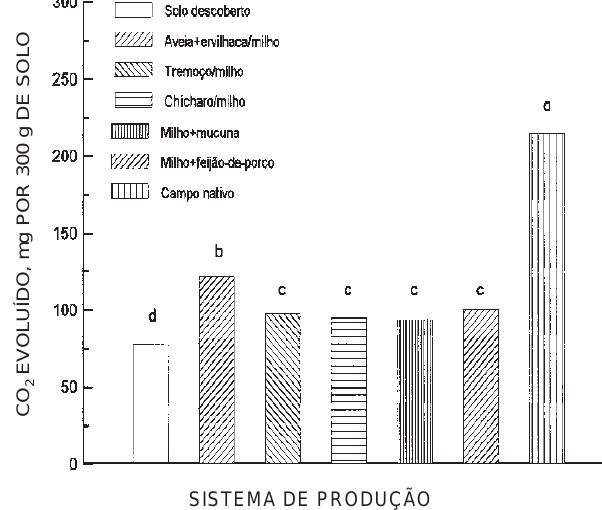
Figura 3. Atividade microbiana, avaliada por meio da evolução do CO 2 , na profundidade de 0 a 5 cm, nos sistemas de produção de milho. Médias seguidas de mesma letra não diferem entre si pelo teste de Duncan ao nível de 5%.